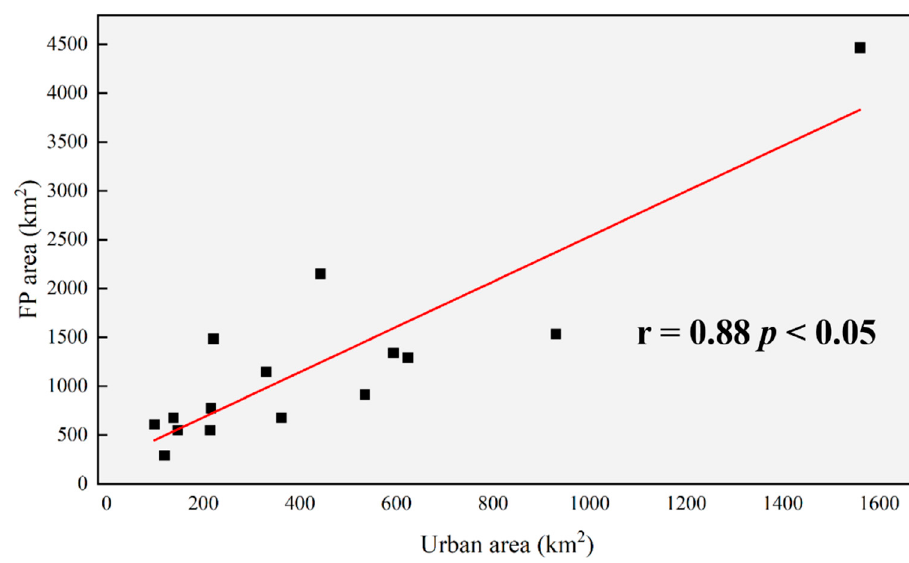
Figure 5. The linear relationship between footprint area and urban area.